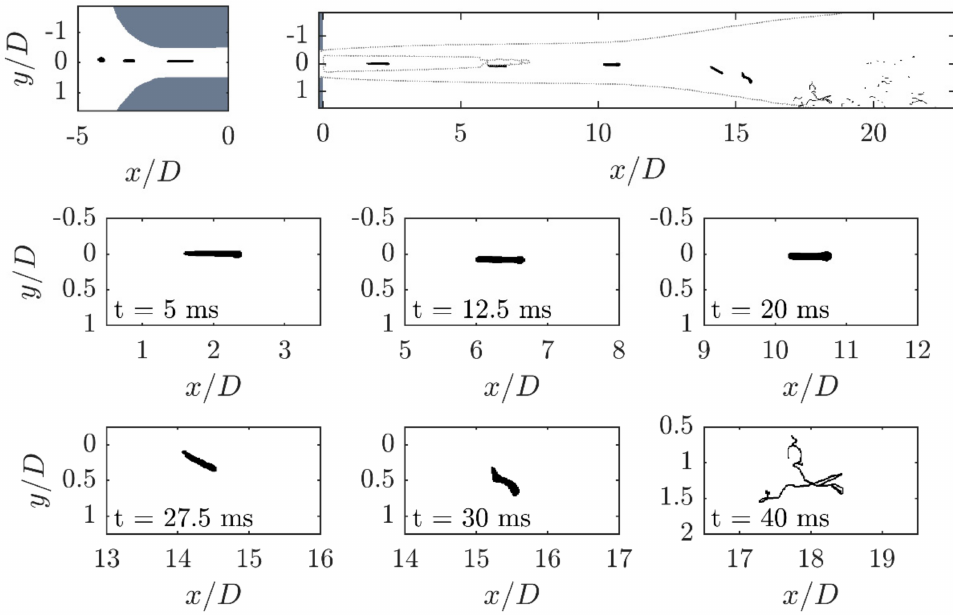
Figure 6. Illustration of the droplet shape as it passes through the orifice and then breaks up at Re = 2000.